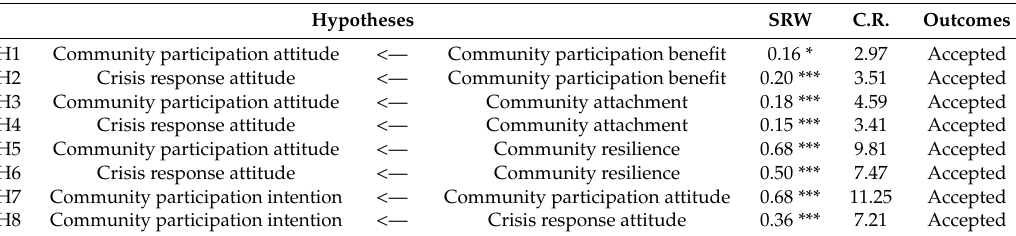
Table 6. Summary of hypotheses testing